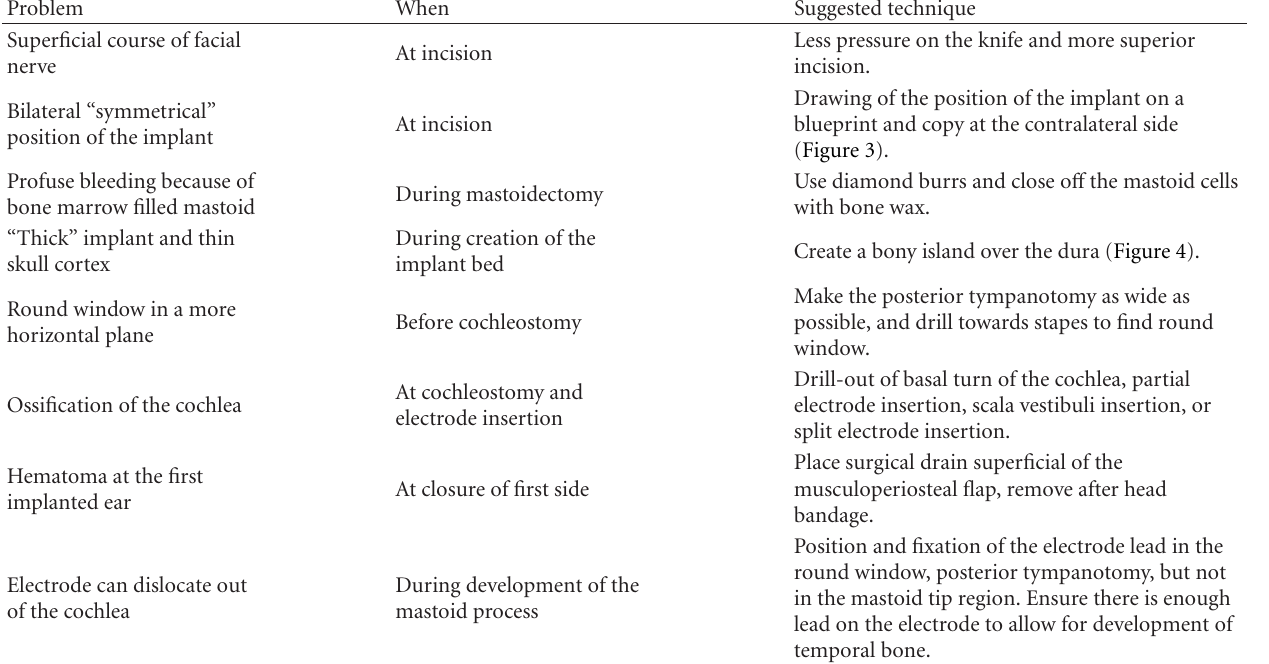
Table 4: Problem solving during cochlear implantation in postmeningitic